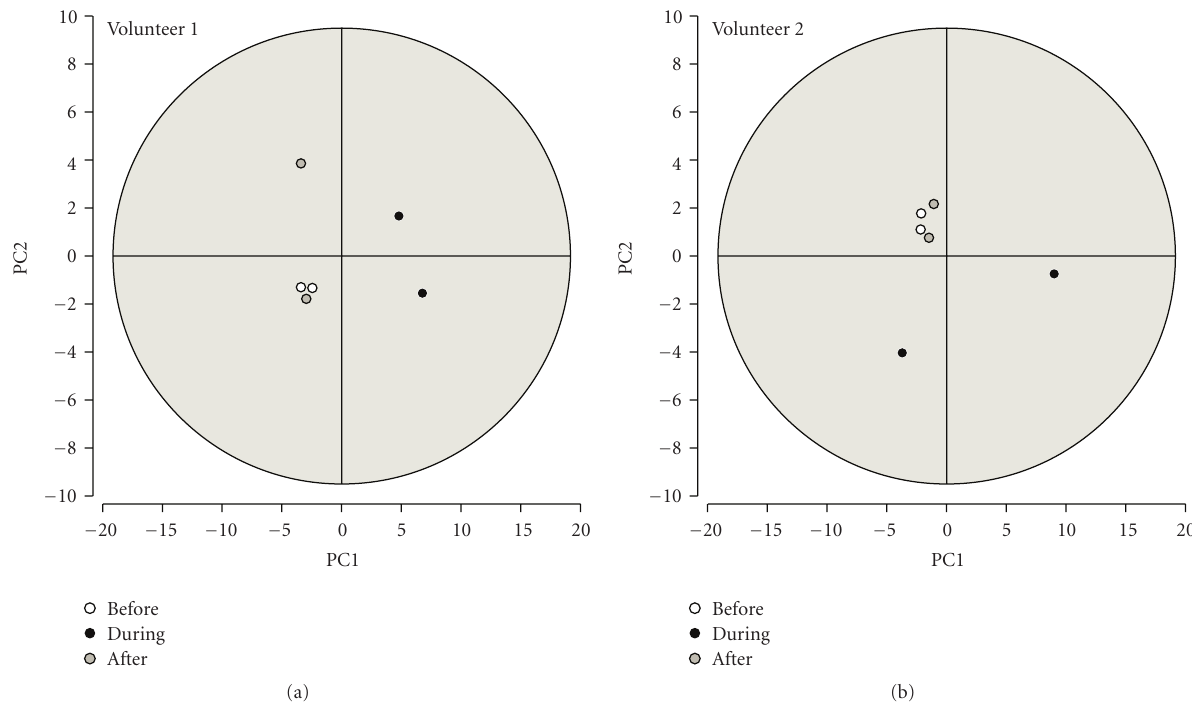
Figure 6: Principal component analysis of before-, during- and after-treatment spot maps of 2 di ff erent volunteers (representative examples).